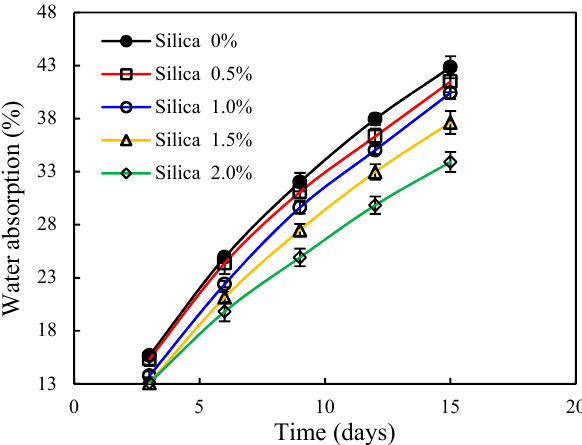
Figure 3. Water absorption of pure polyacrylate film (silica 0 wt.%) and hybrid films with 0.5 wt.%, 1.0 wt.%, 1.5 wt.%, and 2.0 wt.% silica.